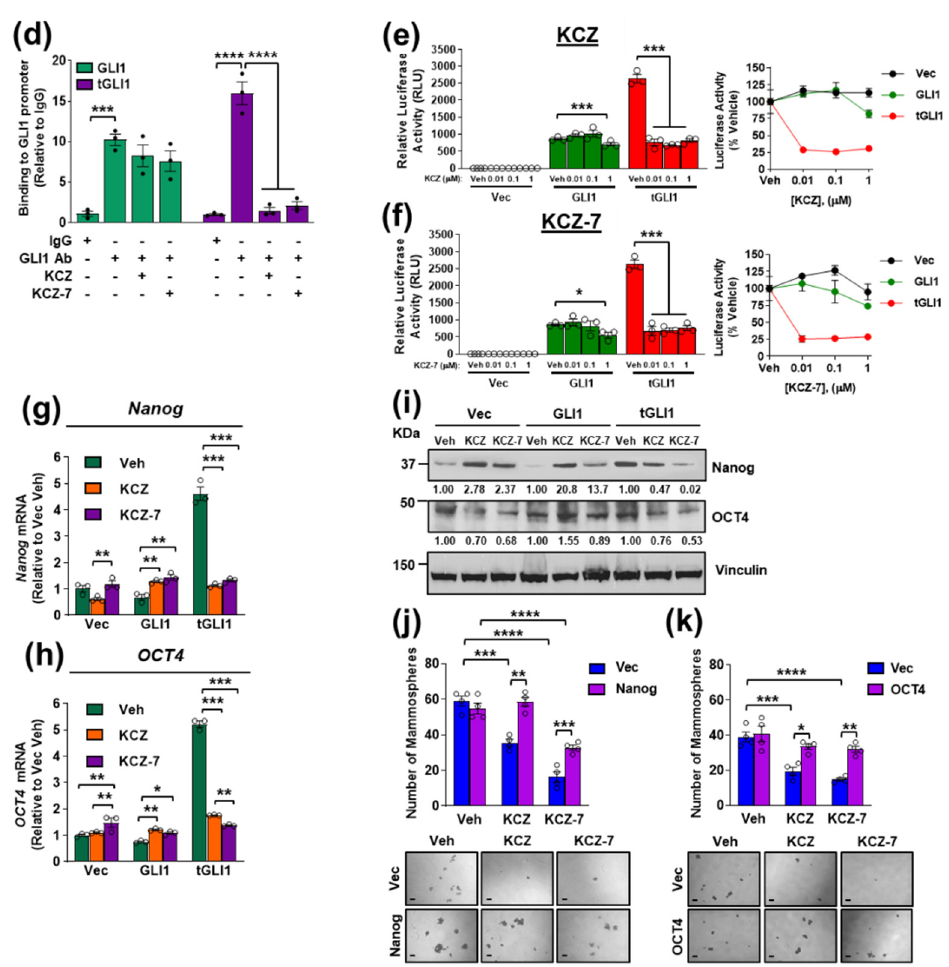
Figure 6. KCZ and the novel derivative KCZ-7 inhibit tGLI1 transcriptional activity leading to downregulation of validated tGLI1-mediated stemness genes Nanog and OCT4 . ( a ) Representative Western blots of GLI1 and tGLI1 expression in isogenic SKBRM cell lines following 24 h treatment with vehicle, 1 μ M KCZ, or 1 μ M KCZ-7. The same membrane was probed to assess the loading control. ( b ) Western blots of recombinant GLI1 and N-tGLI1 (left). A tGLI1-selective Ab was used